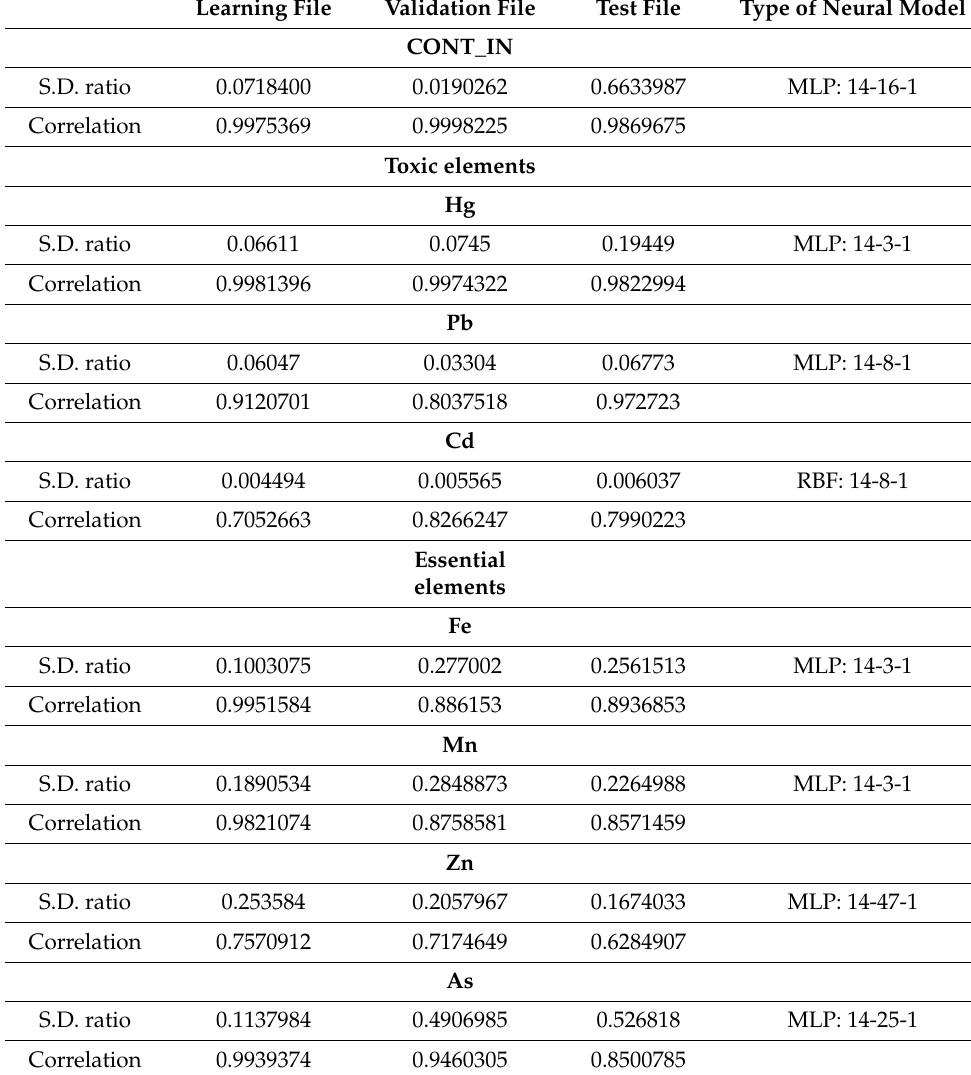
Table 3. Regressions statistics of the obtained optimal neural models. S.D. ratio—quotient of standard deviations determined for errors and for data. Correlation—standard R-Pearson correlation coefficient between the results given by the generated neural model and the actual output